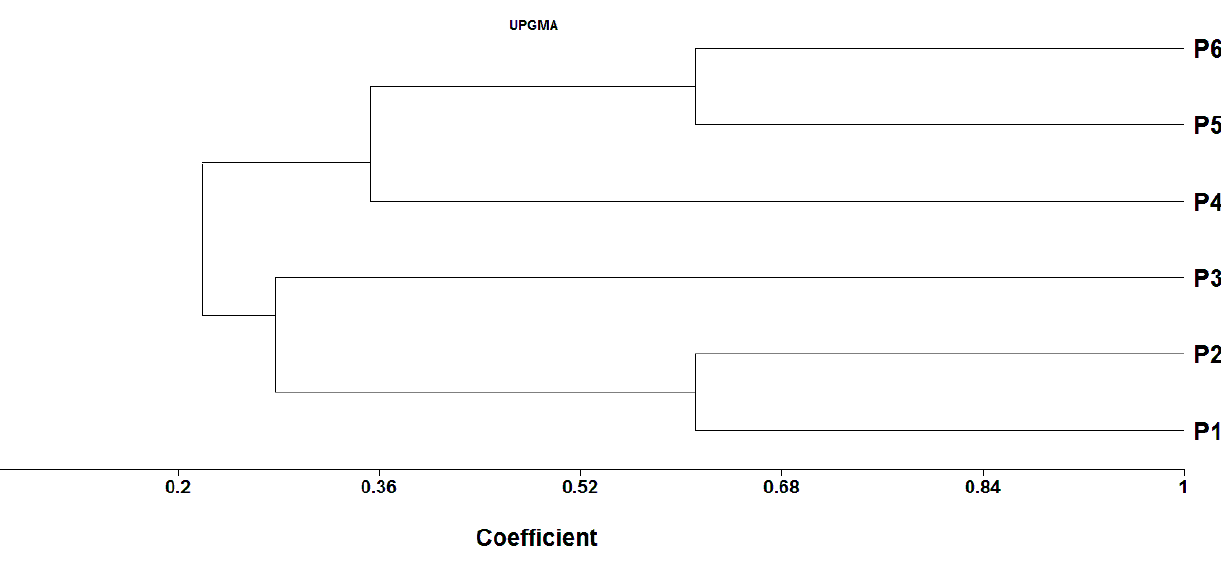
Figure 6. Dendrogram generated from UPGMA cluster analysis of the six parental rice genotypes based on SSR markers. Table 8. Correlation coefficients among parental genetic distance (GD), F 1 hybrid performance, mid-parent heterosis (MP), better-parent (BP) heterosis, and SCA for all the studied traits under well-watered (W) and water-deficit (S)